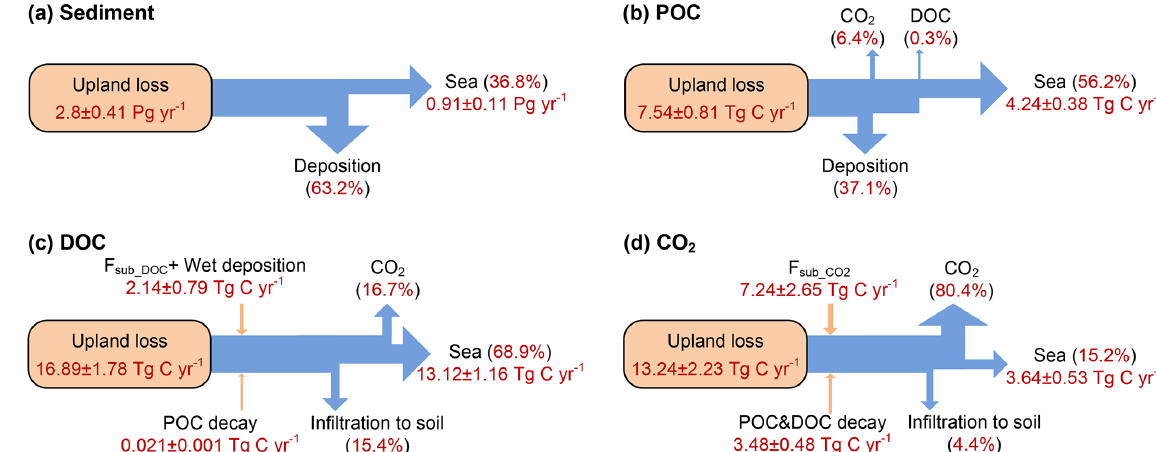
Figure 8. Averaged annual lateral redistribution rate of sediment (a) , POC (b) , DOC (c) , and CO 2 (d) in Europe for the period 1901–2014. F sub_DOC and F sub_CO2 are the DOC and CO 2 inputs from floodplain soil (originating from the decomposition of submerged litter and soil carbon) to the overlying flooding water,